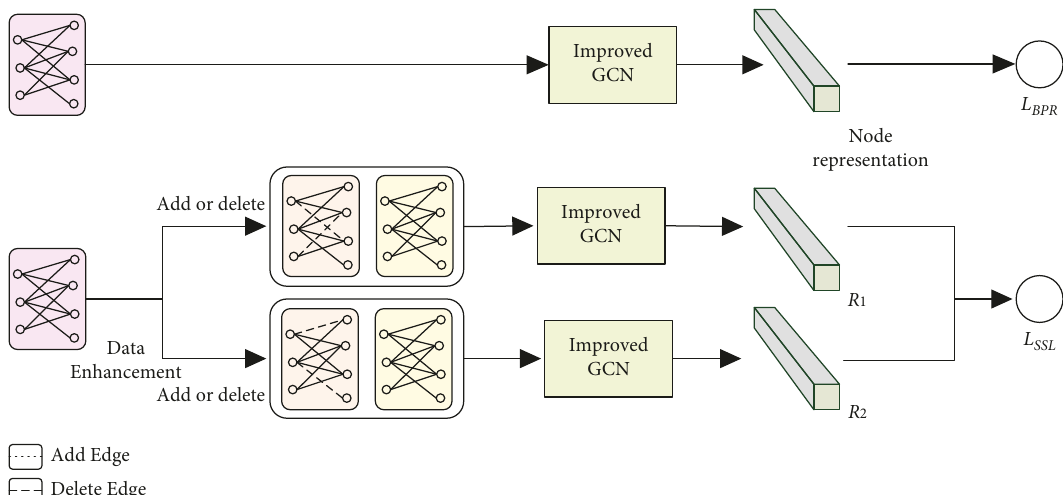
Figure 4: Recommendation algorithm framework diagram.